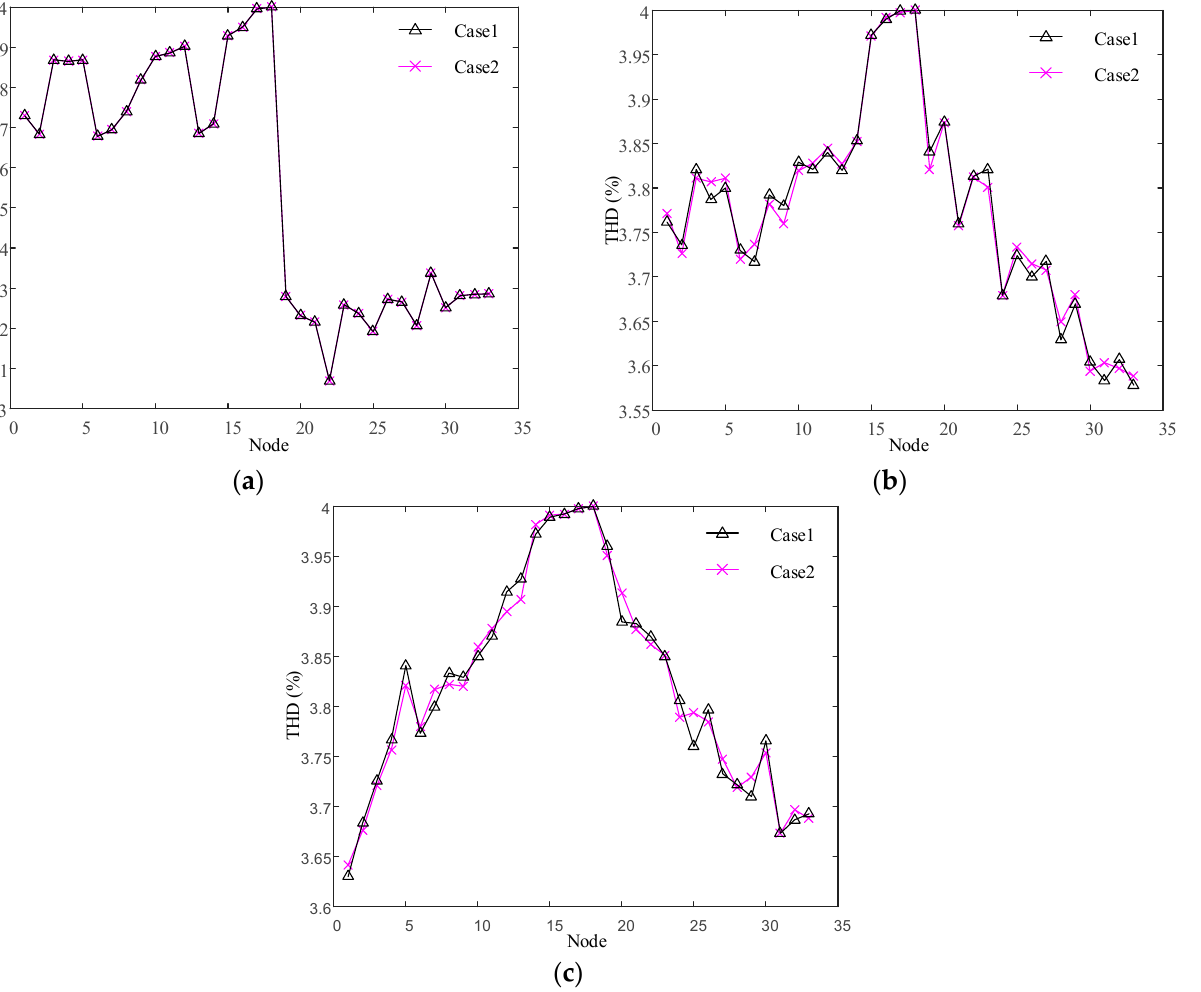
Figure 10. Comparison of system optimization results: ( a ) at 7:00; ( b ) at 13:00; ( c ) at 16:00. Table 12. Capacity comparison of each MFGCI participating in harmonic mitigation (kW).